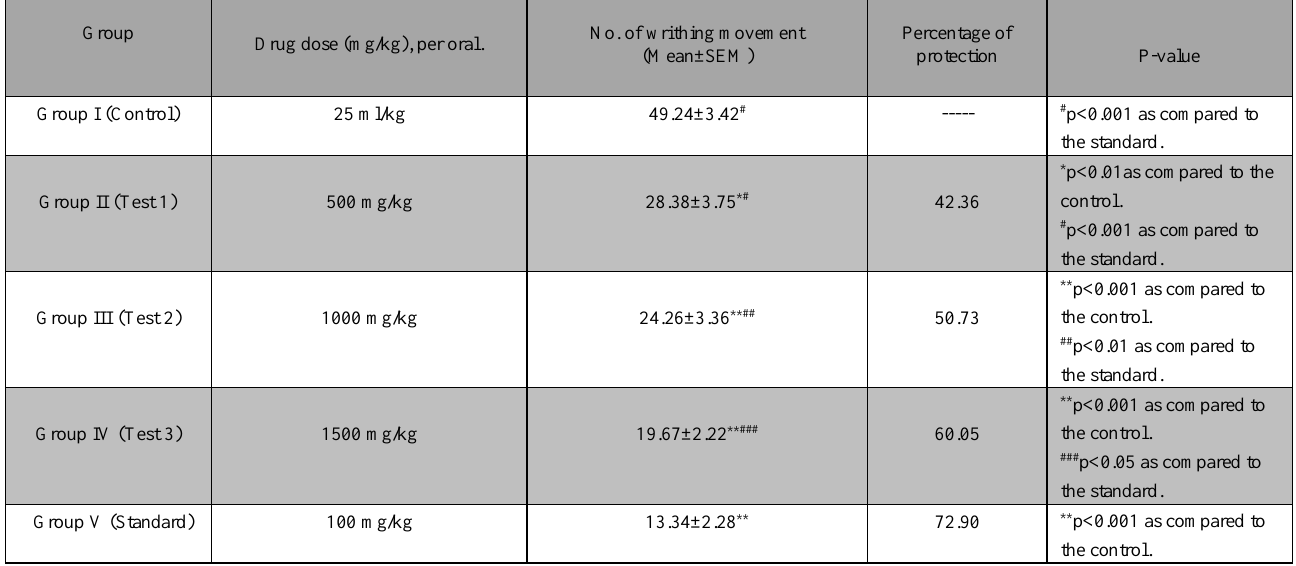
Table 2. An acetic acid-induced writhing test revealed the analgesic activity of the SXB aqueous extract in albino mice. Group Drug dose (mg/kg), per